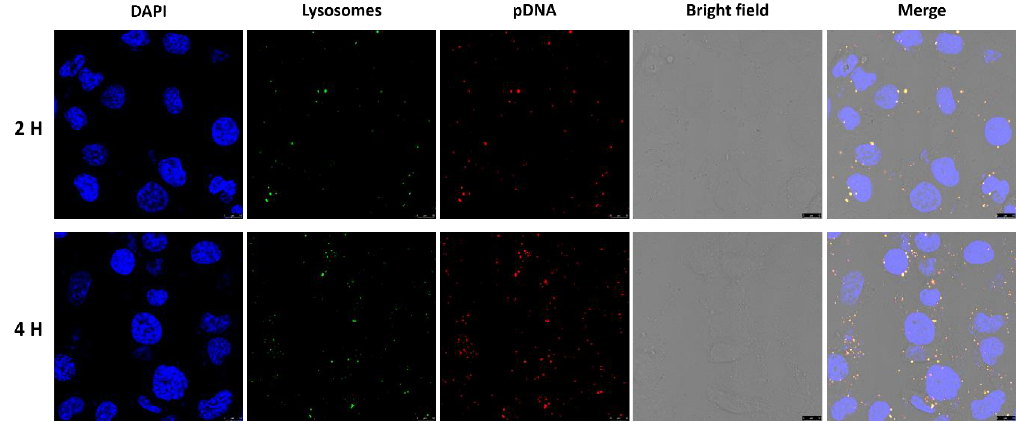
Figure 5. Images of intracellular uptake tests. HUVECs were treated with GPEI polyplexes ( w / w ratio = 5) for 2 and 4 h. Bars = 10 μm. Blue: DAPI; green: LysoTracker Green; red: Cy3-labeled pDNA.